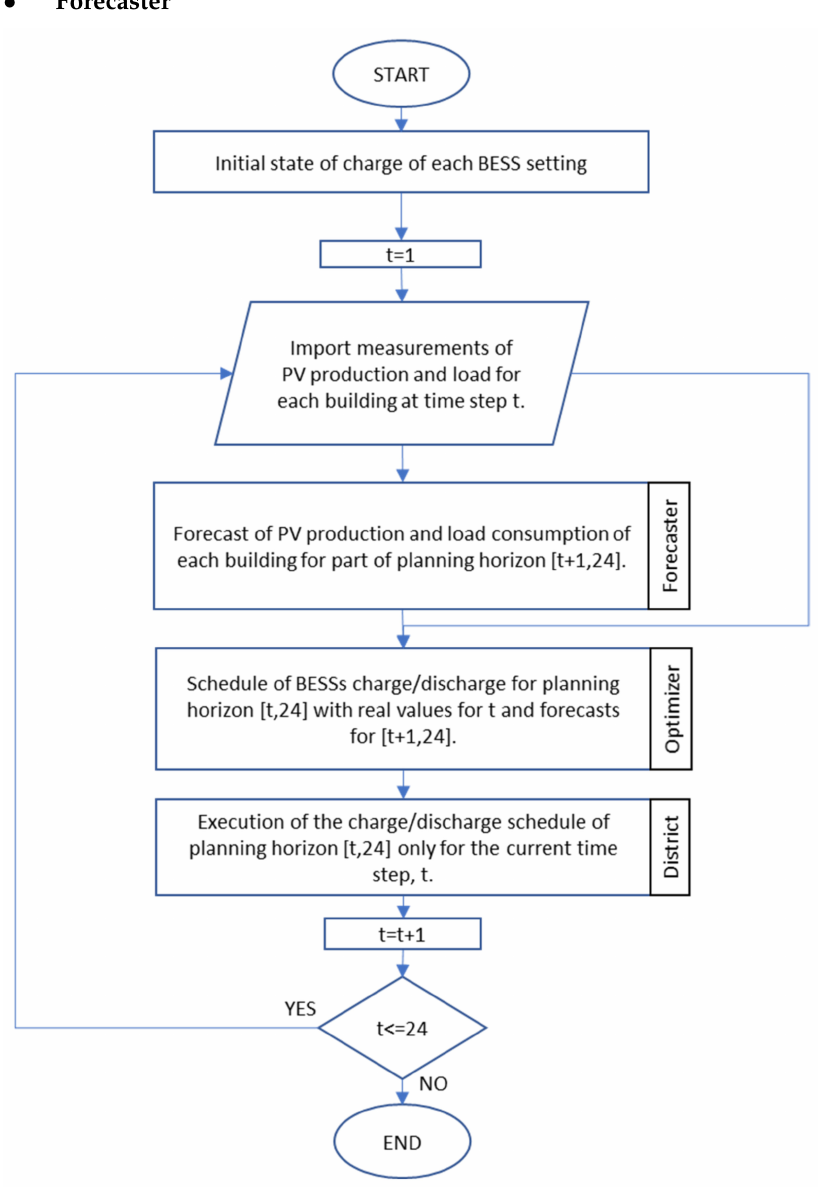
Figure 2. Schematic representation of the